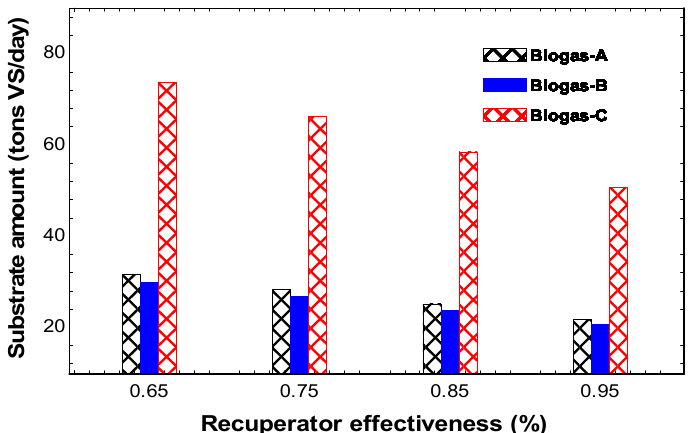
Figure 8. Effect of the recuperator effectiveness on the substrate amount required for biogas pro- duction in the CHP system.